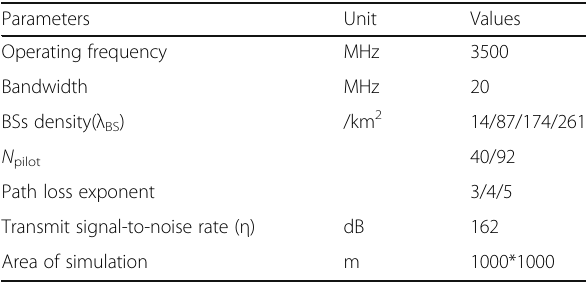
Table 2 Simulation